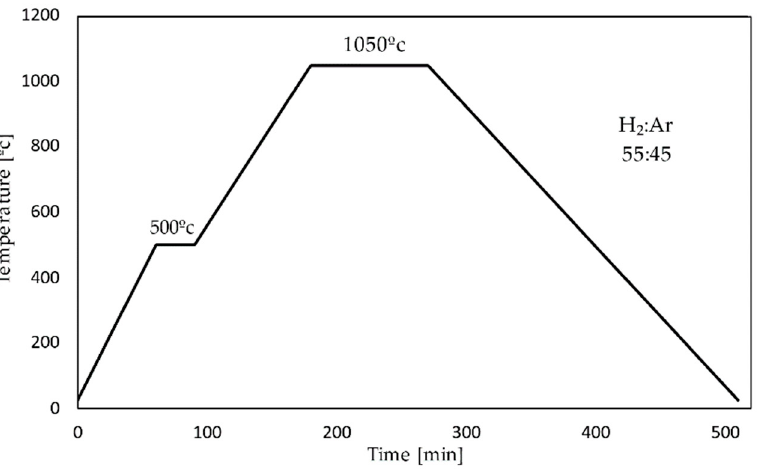
Figure 1. Scheme of the used heat treatment—temperature program; heating rate—step I—7.9 °C/min, step II—6.1 °C/min; cooling rate—4.3